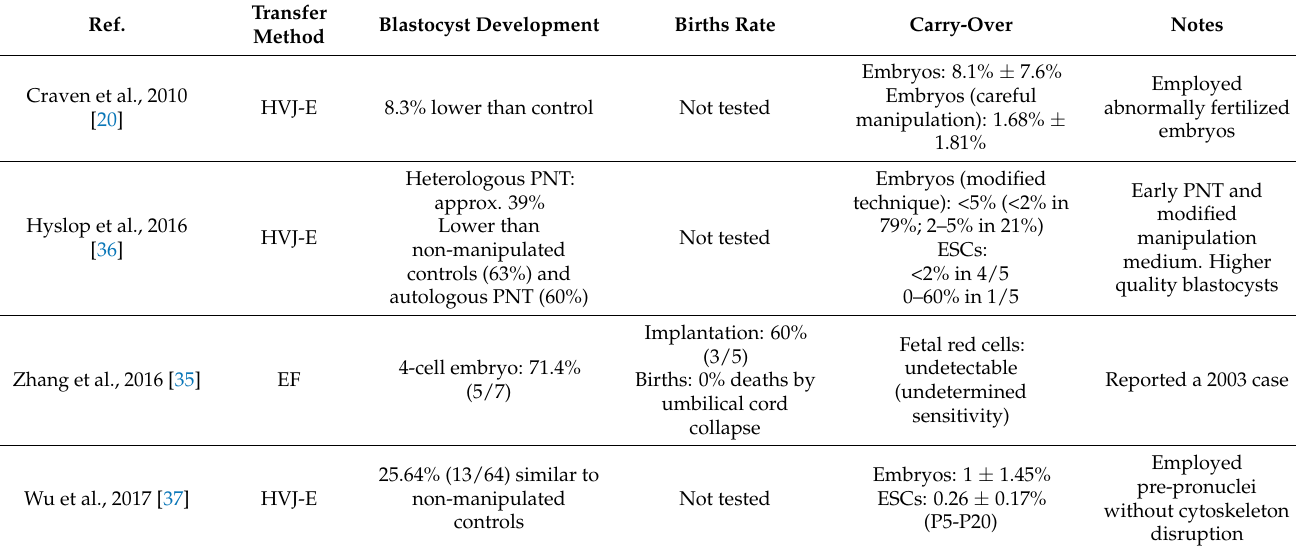
Table 6. Results of PNT in